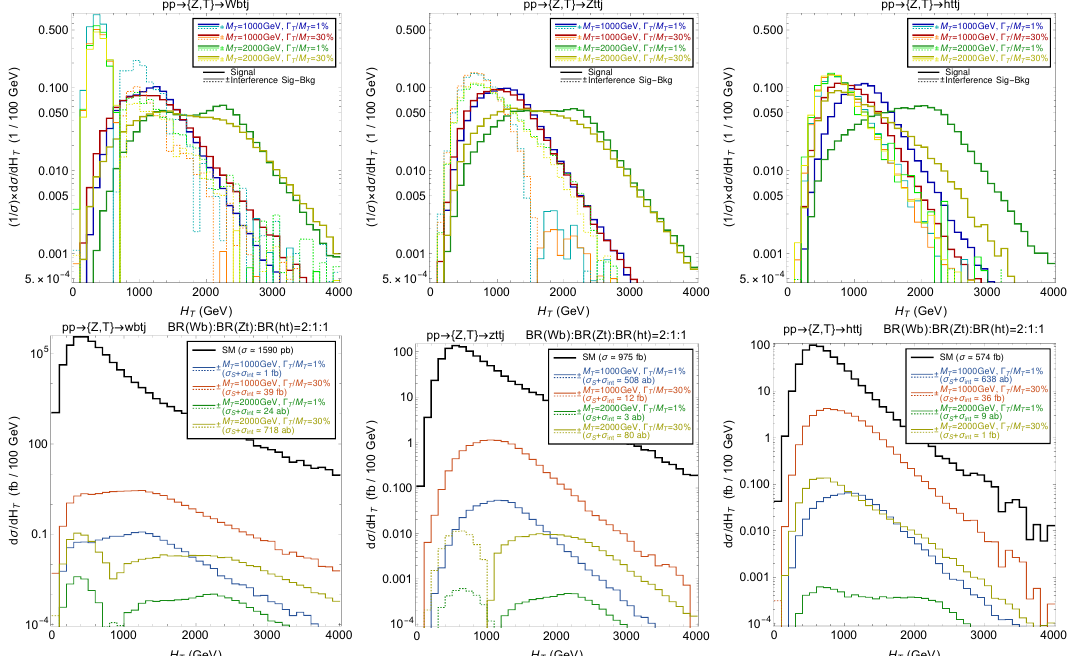
Figure 24 . H T distribution at the reconstructed level for the pp → Wbtj (left), Zttj (centre) and httj (right) processes and for two values of the T mass ( 1000 GeV and 2000 GeV ) and two values of the Γ ratio (1% and 30%). In the top panel we show the shapes of the H T /M T for the pure signal component, and for its interference with the SM. In the bottom panel the sums of signal and interference are displayed, as obtained following eq. (3.15). We consider a choice of couplings corresponding to the singlet case (see figure 9), and compared with the distribution of SM background. For the Zttj case, the large particle multiplicities in the final state makes the Monte Carlo integration very resource-consuming. We have consequently simulated the decay of the Z -boson through Pythia 8